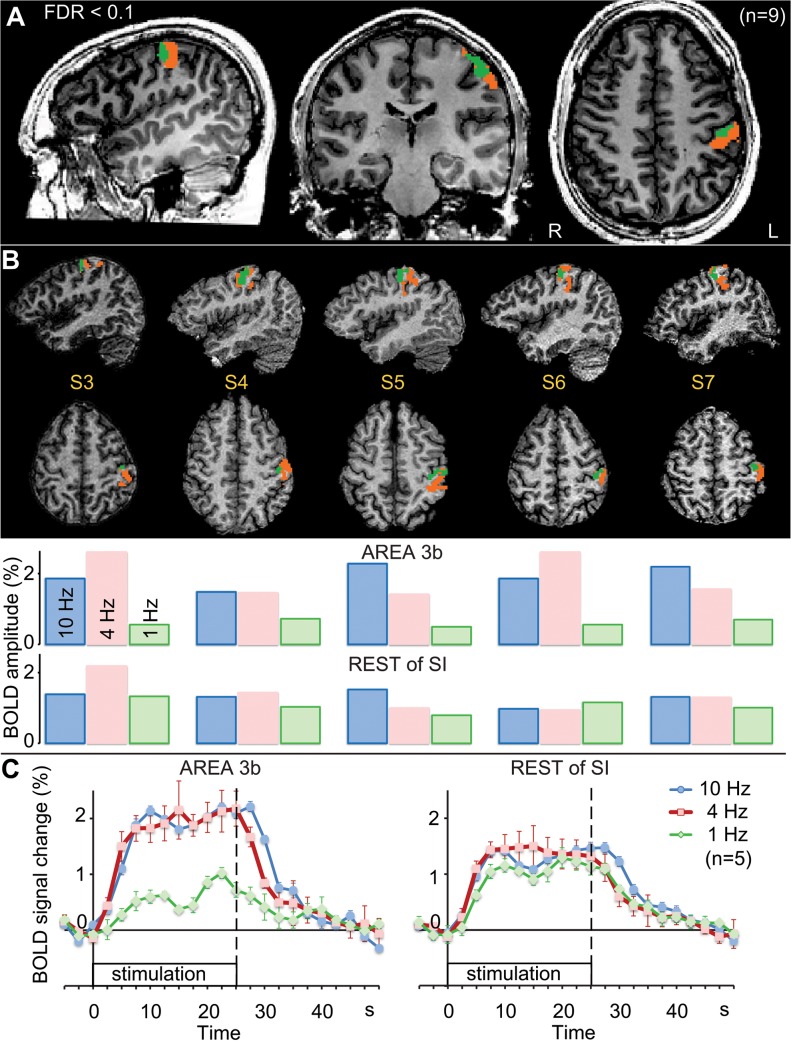
Stimulus-rate sensitive subcluster within SI.A. Group results (n = 9): The statistical map overlaid onto one subject’s Talairach-normalized anatomical images. Contrast ([1Hz] + [4Hz] + [10Hz] – [baseline]) at false-discovery rate q(FDR) < 0.1 was used to define SI activation cluster (orange + green colors). The green color demarcates the stimulus-rate sensitive subcluster in SI obtained in the conjunction of the contrasts: [4 Hz − 1 Hz] > 0 and [10 Hz − 1 Hz] > 0 (presumably area 3b; see Results). B. Individual subjects’ results: Stimulus-rate sensitive subclusters within SI corresponded to the conventional location of area 3b in 5 out of 9 subjects. The stimulus-rate sensitive cluster “AREA 3b” is marked with green color, while the “REST of SI” cluster with orange. The SI cluster was defined at q(FDR) < 0. 1, and in the subsequent search for stimulus-rate sensitive voxels within that cluster, the statistical threshold was q(FDR) < 0.1 (see Methods for details). The bar graphs show for each subject and each SR the BOLD-response amplitudes in “AREA 3b” (top row) and in the “REST of SI” (bottom row) clusters (estimated as the average % BOLD response across the stimulus block, starting 5 s after stimulus onset and ending 5 s after stimulus offset). C. Response time courses: The insets show the BOLD responses (mean ± SEM) for the stimulus-rate sensitive cluster “AREA 3b” (on the left) and for the rest of the SI cluster (on the right). The data correspond to the average of the individual clusters shown in panel B (n = 5).